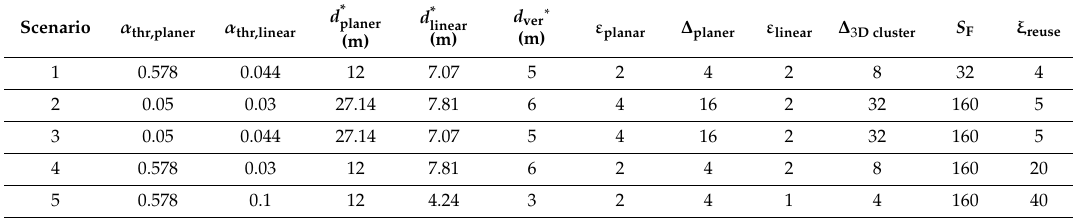
Table 2. Co-channel interference e ff ect on 3D clustering and resource reuse